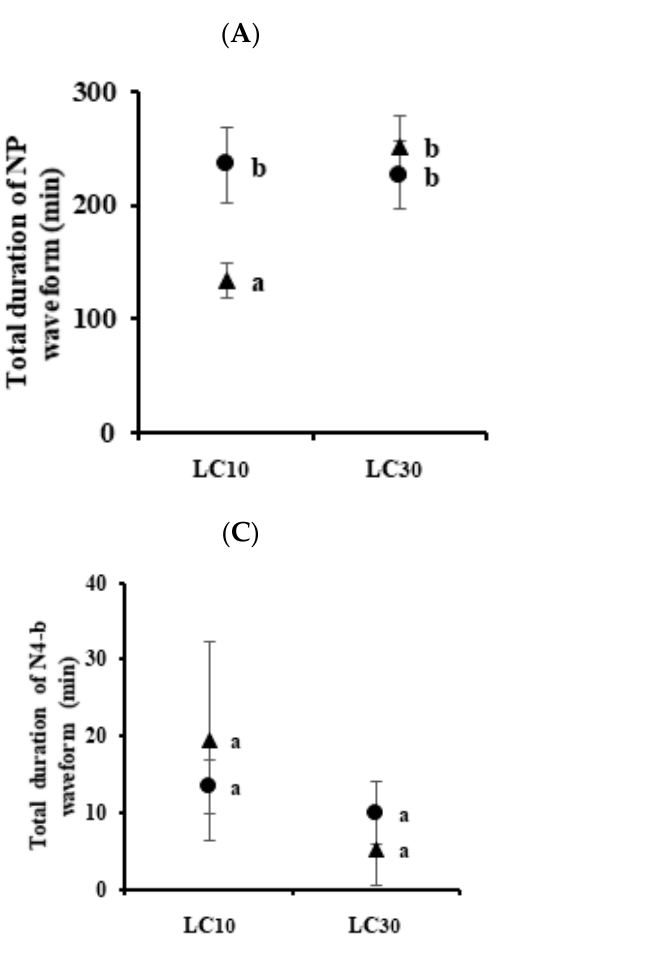
Figure 5. Total duration for each waveform of N. lugens and S. furcifera treated with LC 10 and LC 30 concentrations of sulfoxaflor. Panel ( A ) is the duration of the NP waveform, panel ( B ) is the N4-a waveform, panel ( C ) is the N4-b waveform, and panel ( D ) is the N5 waveform. Circles are Nilaparvata lugens and triangles are Sogatella furcifera . Means followed by the same letters are not significantly different ( p = 0.05; Tukey’s studentized range test (SAS Institute 9.0 (SAS, 2009)). Error bars indicate ± SE.